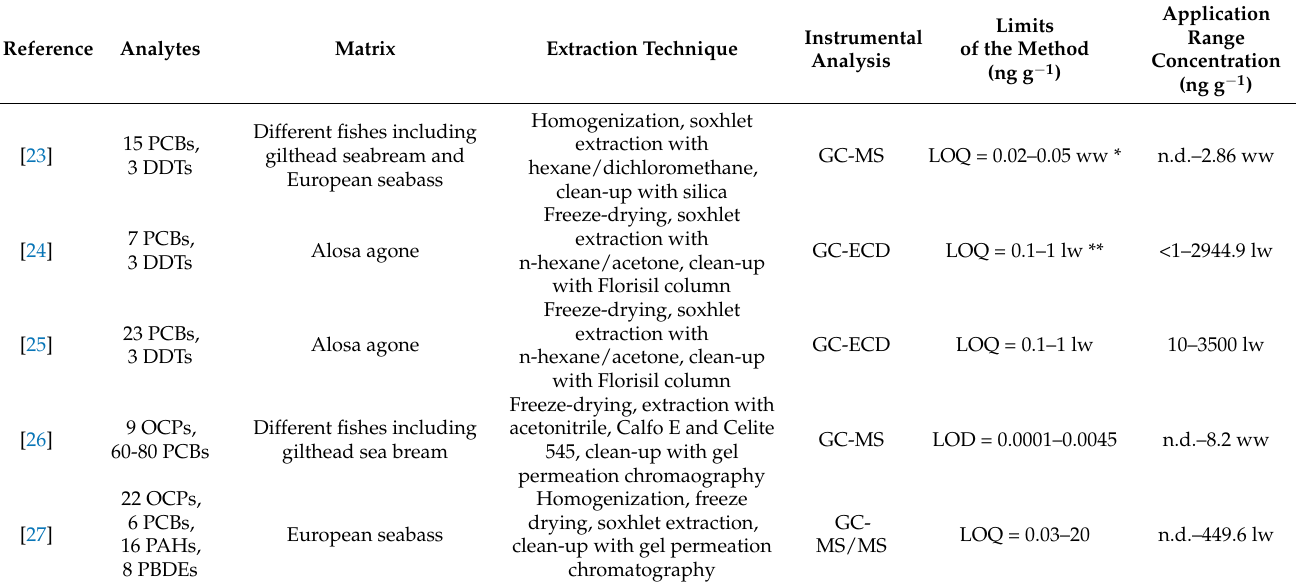
Table 1. Recent works present in the literature regarding the detection of POPs in sea or lake